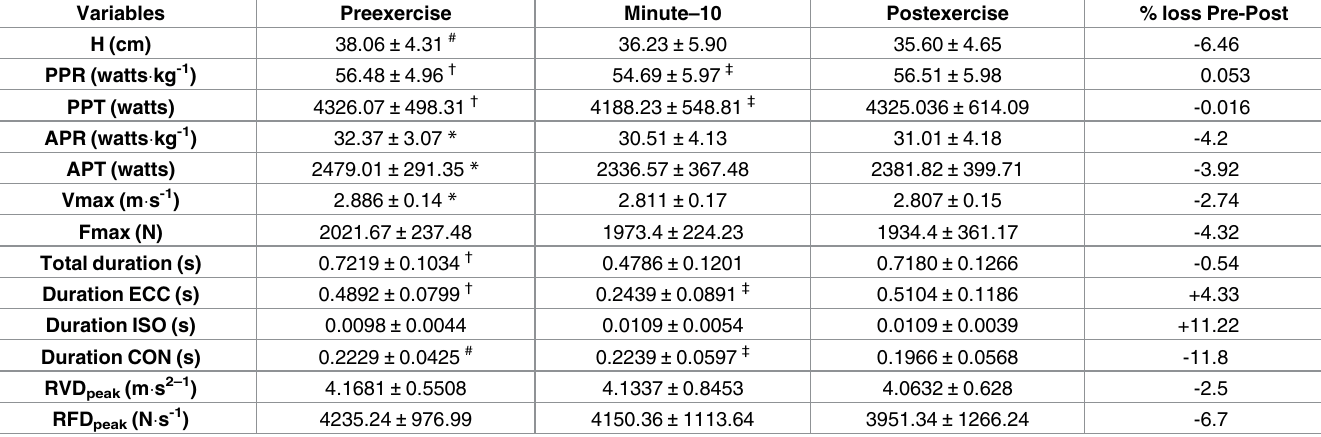
Table 4. Variables reflecting muscular fatigue recorded at the 3 time points of the gymnastics WOD in the 34